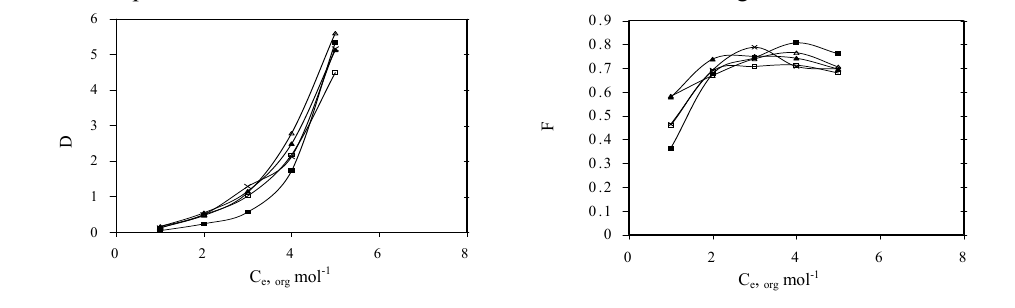
Figure 2. Variation of loading factors with concentration of Amberlite LA-2 in different diluting diluents at 25 0 C. ( ∆ , 1- octanol; ■ , MIBK; ▲ , Isooctane; x, Cyclohexane; □ , Hexane)